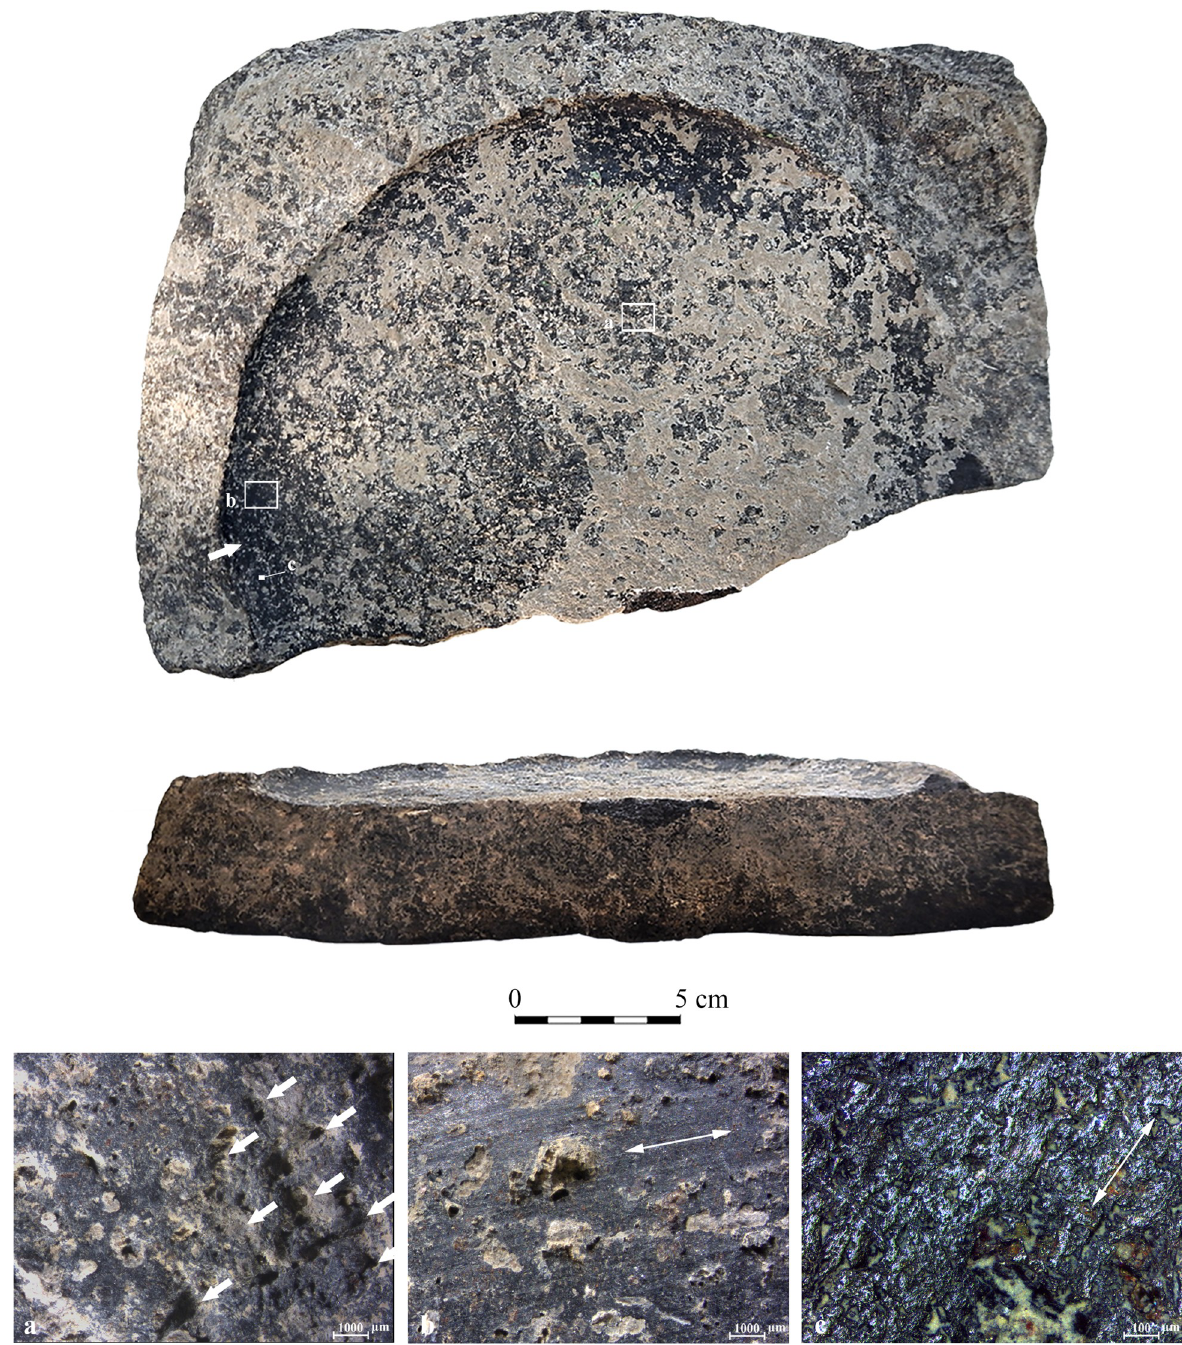
Fig 13. Archaeological vessel KB from Kabri, dated to the Early Bronze Age I, with surface darkening along the circumferential depression marked by a small arrow. (a) Clear pecking marks on the elevated center shown by arrows (10x); (b) Flat, leveled, striated surface of the circumferential depression with the orientation of the striations marked by a double-headed arrow (10x); (c) A heavy polish showing a reticular pattern, associated with striations in an orientation marked by a double-headed arrow along the circumferential depression (100x).